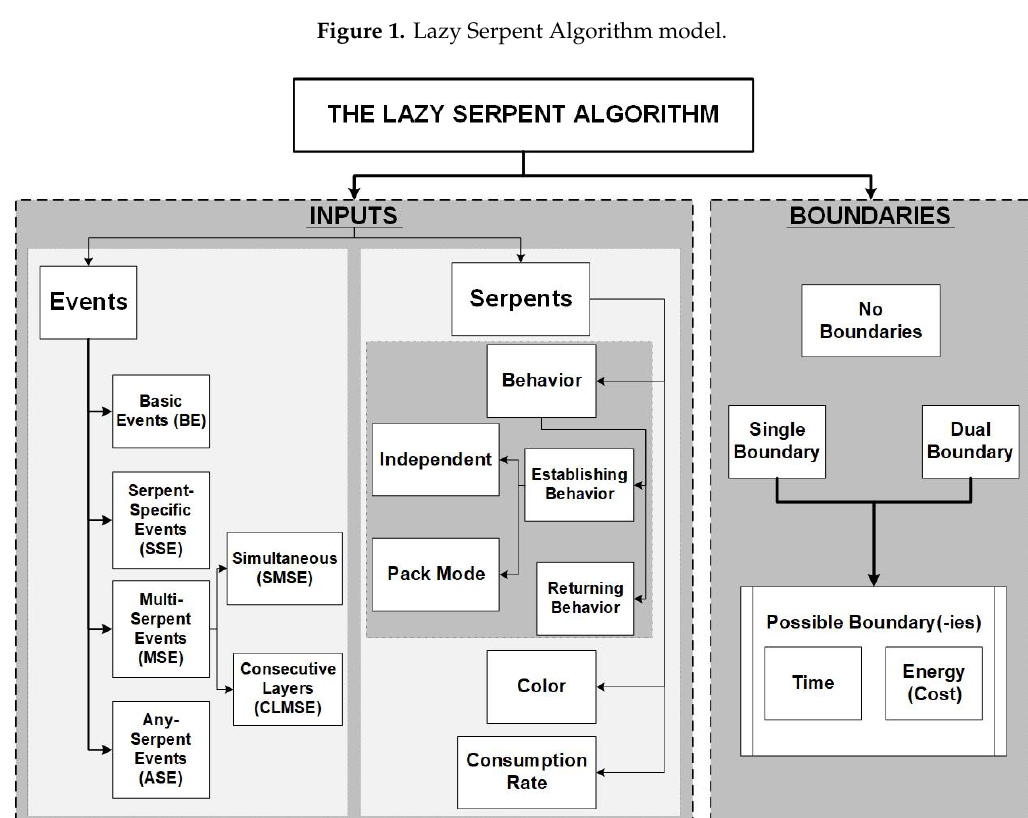
Water 2020 , 12 , x